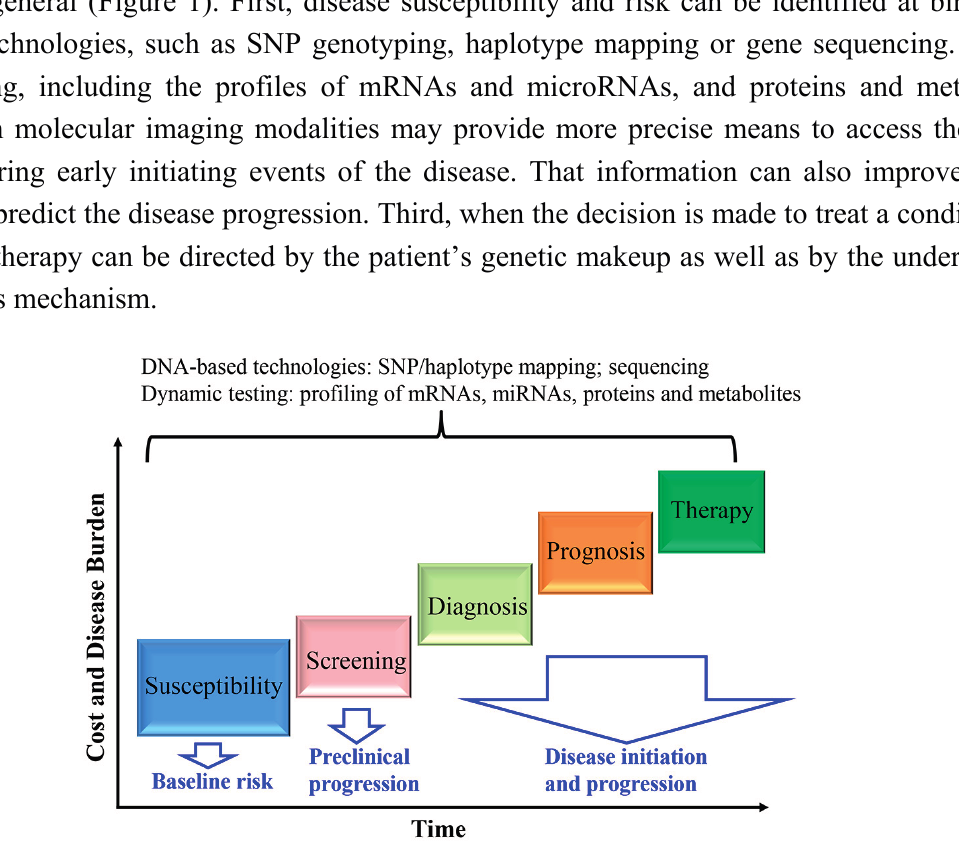
Figure 1. Applications of the human genome to personal